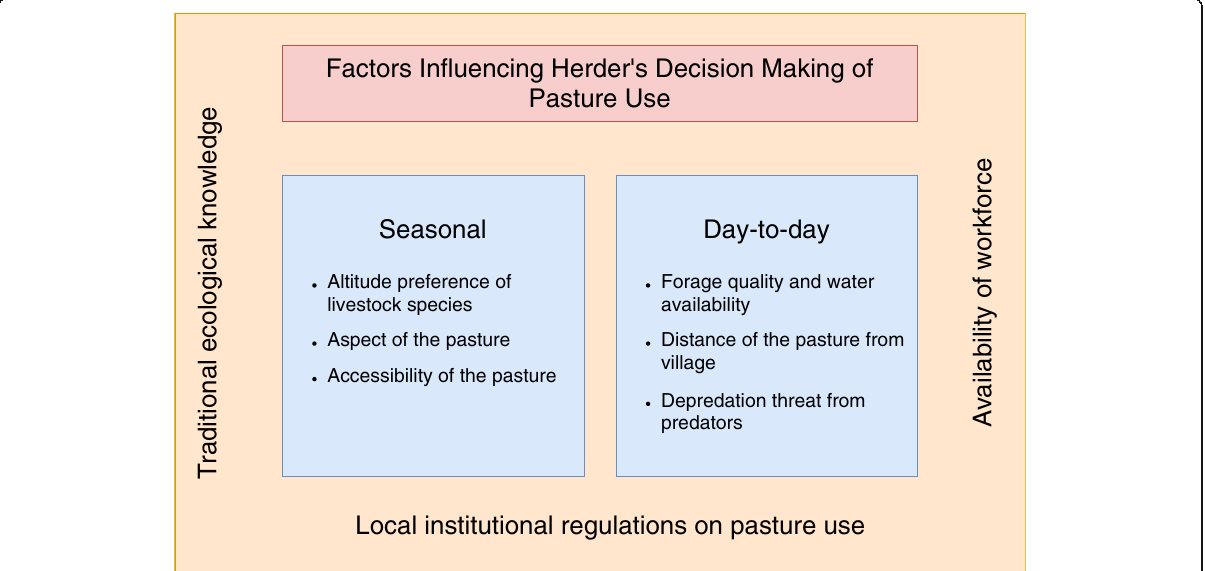
Fig. 2 Factors influencing decision-making for resource use: aspect, altitude and accessibility of the pasture on seasonal basis and distance from the villages, forage quality, water availability and threats from predators on daily basis were found to be important ecological factors influencing the decisions of herding practices. The ecological factors work in consonance with the social factors like availability of workforce and TEK of the herders and rules and regulations of local institutions regulate access and use of the